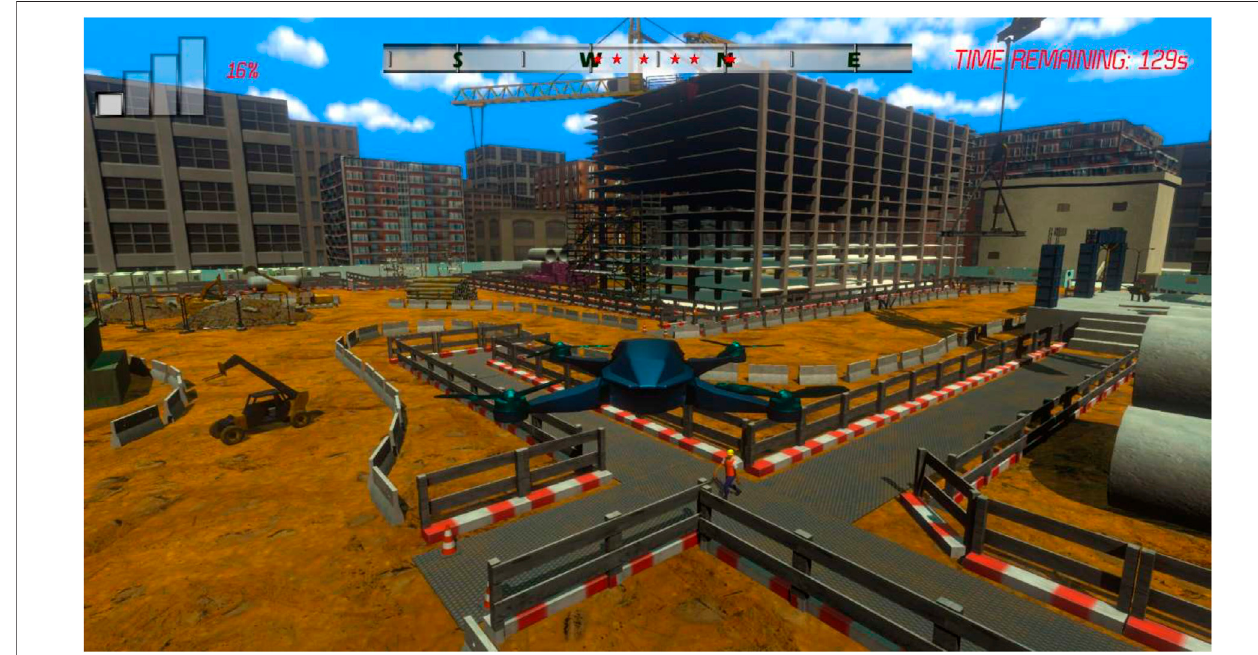
FIGURE 11 | Screenshot of game showing pedestrian access routes on the construction site.